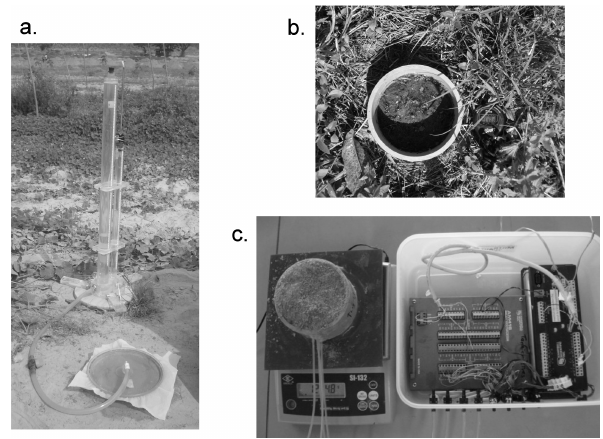
Figure 2. Photographs of some of the experimental measurement methods: (a) disc infiltrometer; (b) Beerkan method; and (c) evapo- ration